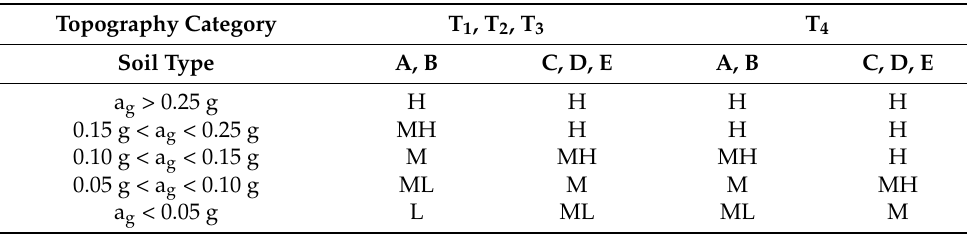
Table 1. Classification based on the hazard primary parameters. Topography